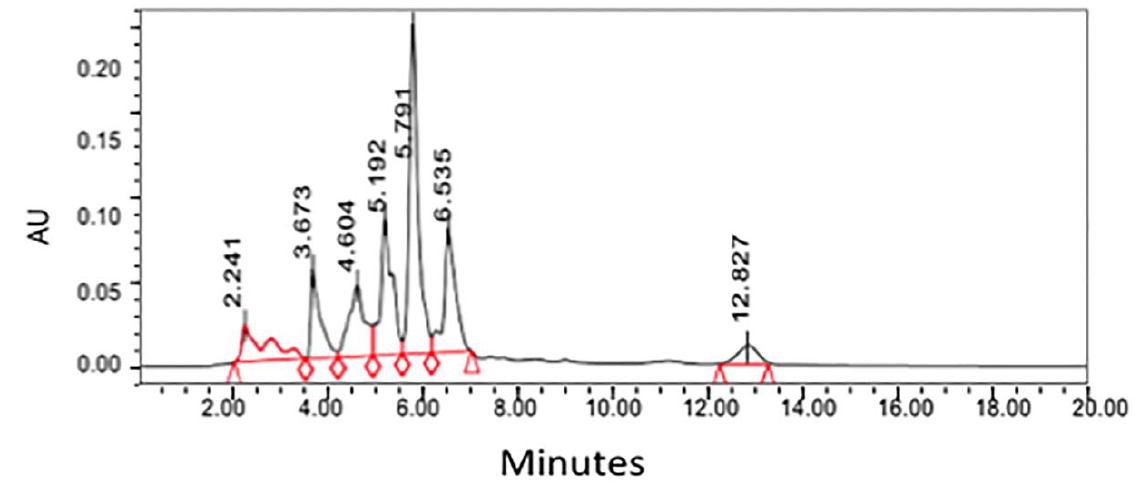
Figure 3. HPLC chromatogram for chloroform extract from Artemisia cina [39]. Peak at 5.7 represents santonin and quantified by the standard of santonin run with same HPLC condition.